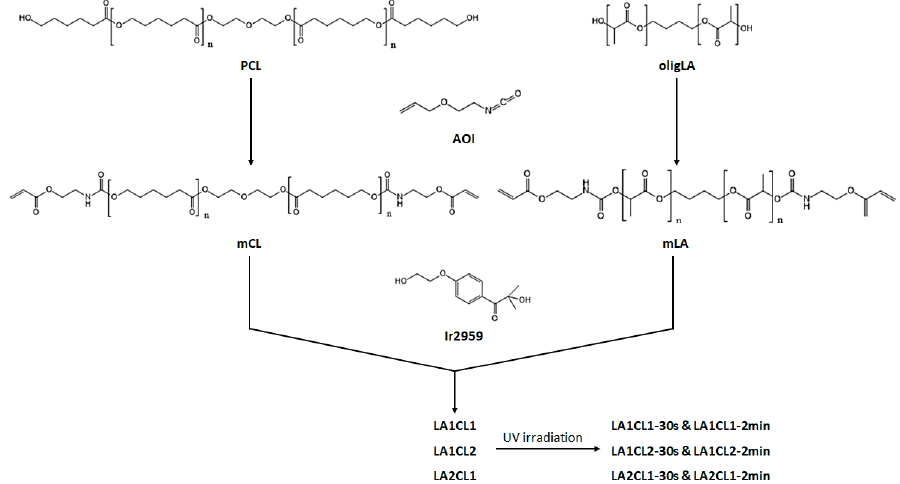
Figure1. Figure 1. Schematic representation of the macromers synthesis and preparation of the three different blends.